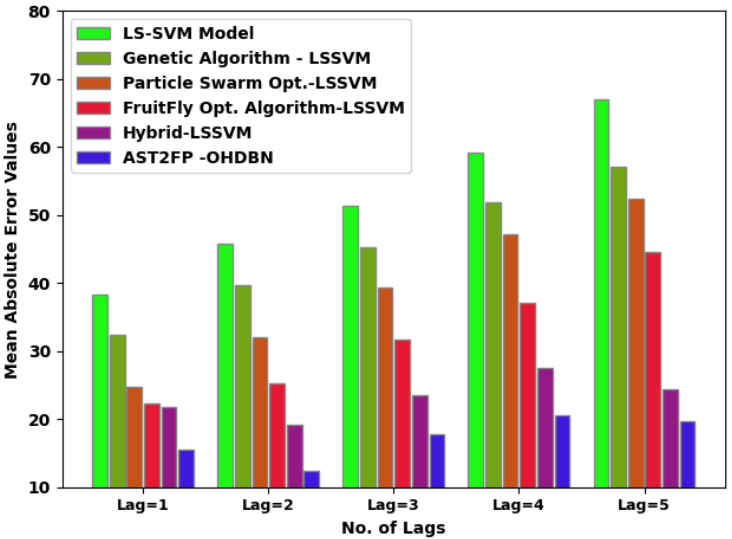
Figure 6. MSE analysis of AST2FP-OHDBN approach with existing methodologies.